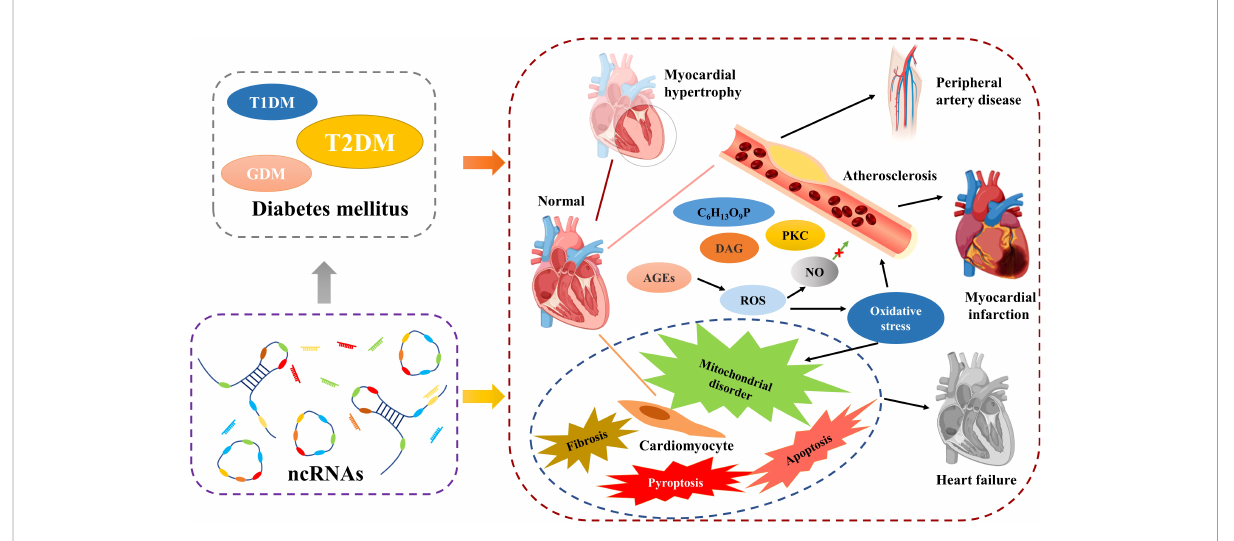
FIGURE 4 NcRNAs are participating in the development of diabetic